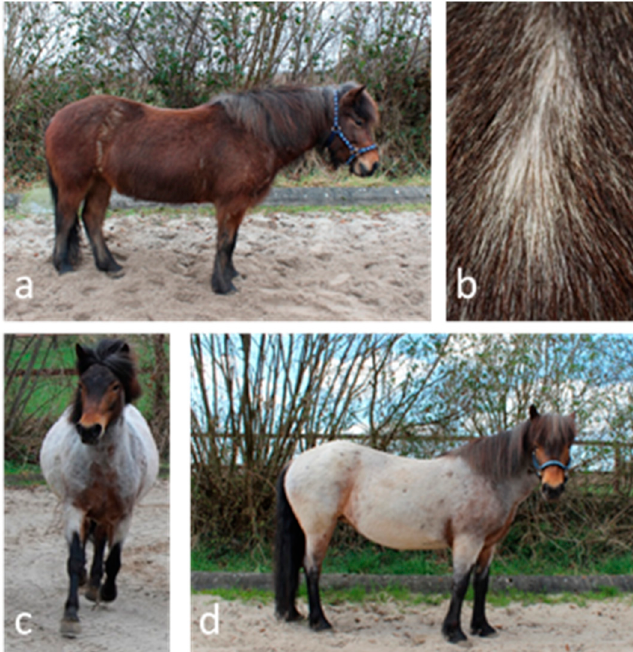
Figure 1. Phenotype of roan Icelandic horse ( a – d ): Phenotype of roan coat color of an Icelandic horse. All photographs show the same horse. ( a ) Roan horse during winter: Colored covering coat hides white undercoat. ( b ) Covering coat pushed aside, undercoat is visible. ( c ) Characteristic inverted ‘V’ on the foreleg. ( d ) Roan horse during spring: when the covering coat is shed, the white undercoat becomes visible on the horse ′ s body, with lower legs and head unaffected.